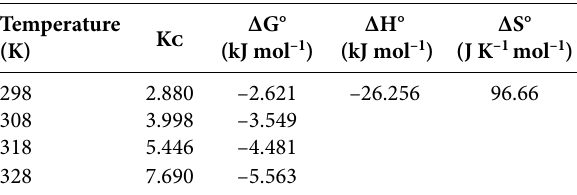
Table 4. Thermodynamic parameters for MB adsorption by nano- zeolite